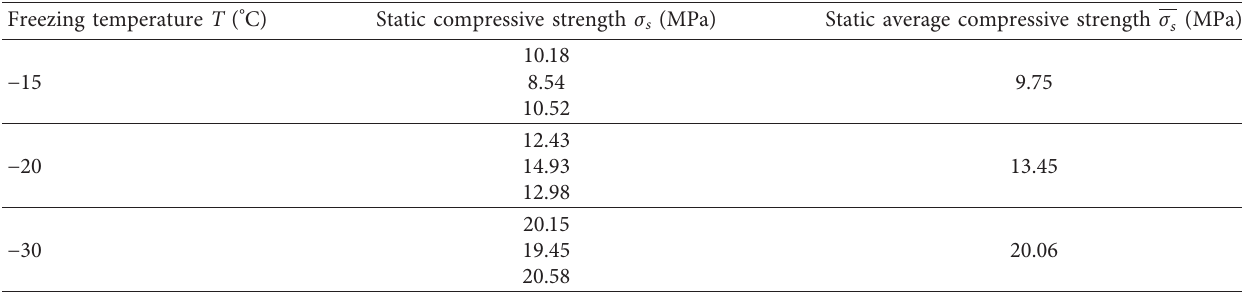
Table 2: Uniaxial compression test results of the frozen fine